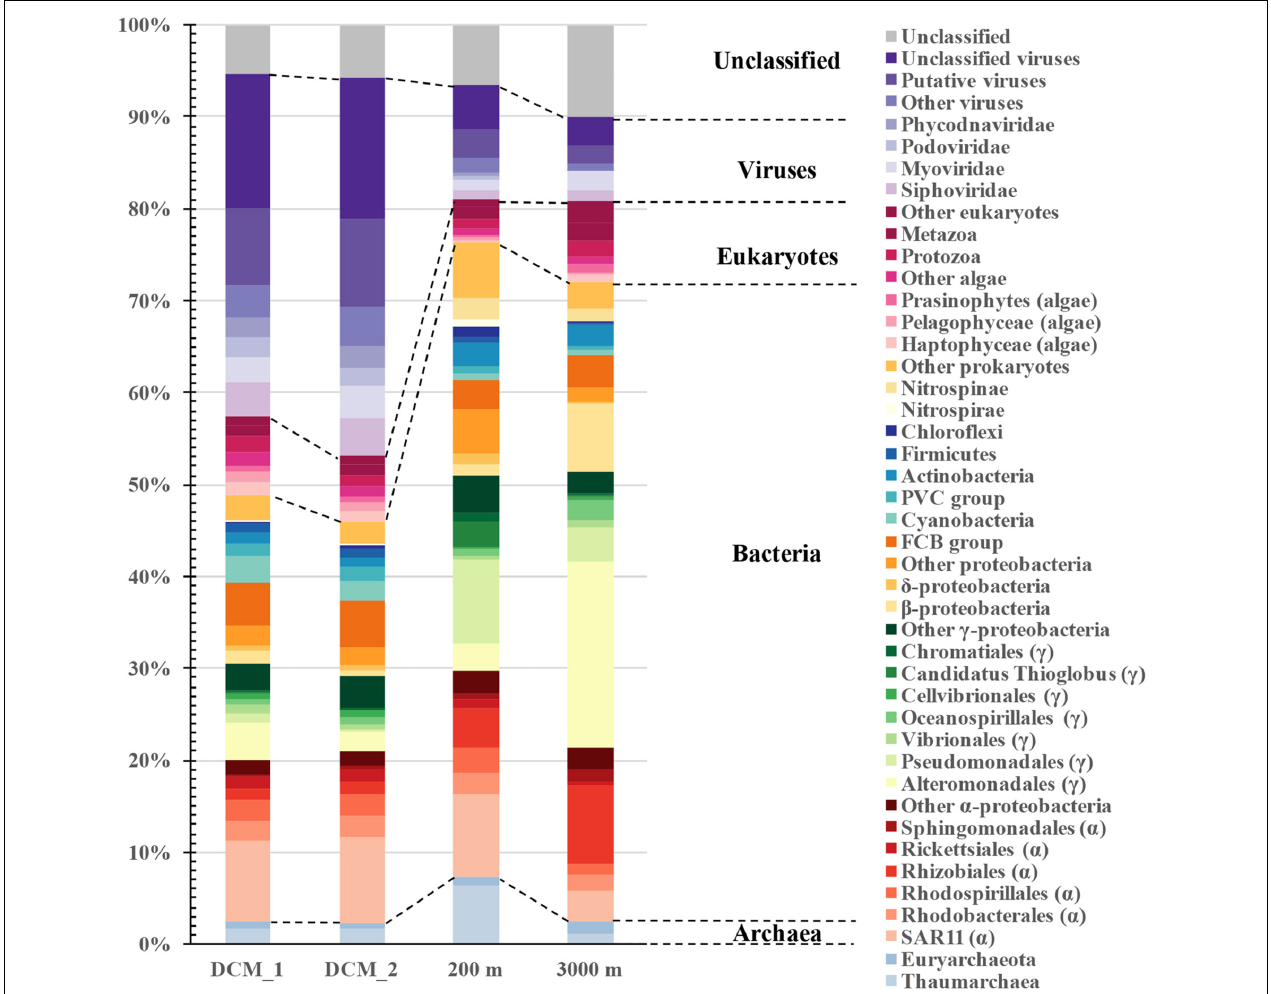
FIGURE 2 | Distribution of vertical exoprotein profiles in the SCS in terms of their microbial origins. Data are represented as percentage of total relative abundance of each